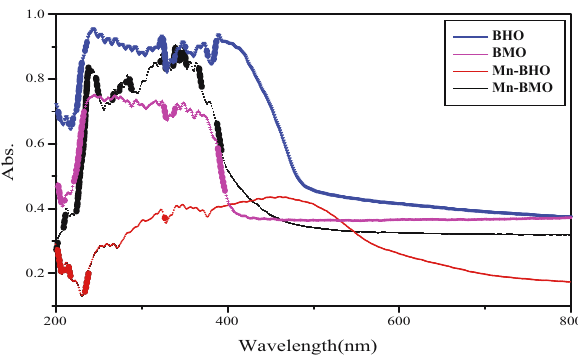
Figure 2: UV - Vis spectrum of free ligands and manganese ( II ) complexes in Nujol